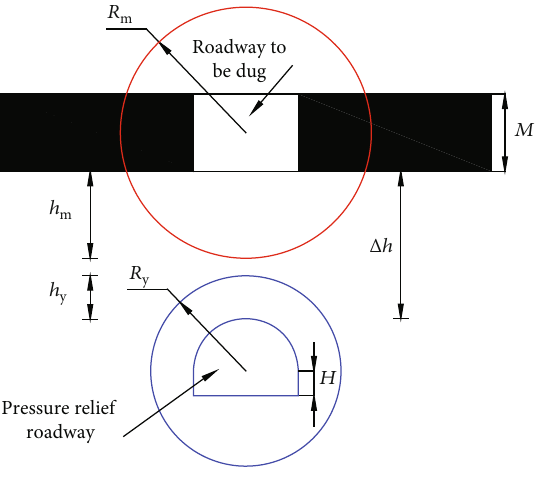
Figure 2: Calculation model of pressure relief roadway